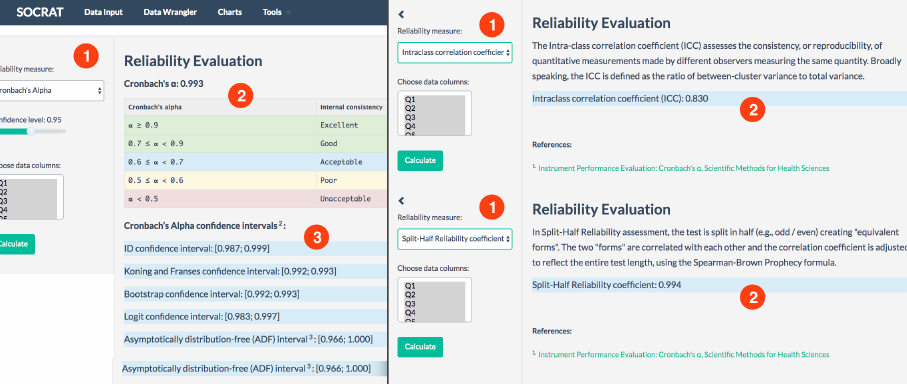
Figure 12. Reliability evaluation module: ( 1 ) Metric selection, ( 2 ) computed result and interpretation, ( 3 ) Cronbach’s alpha confidence